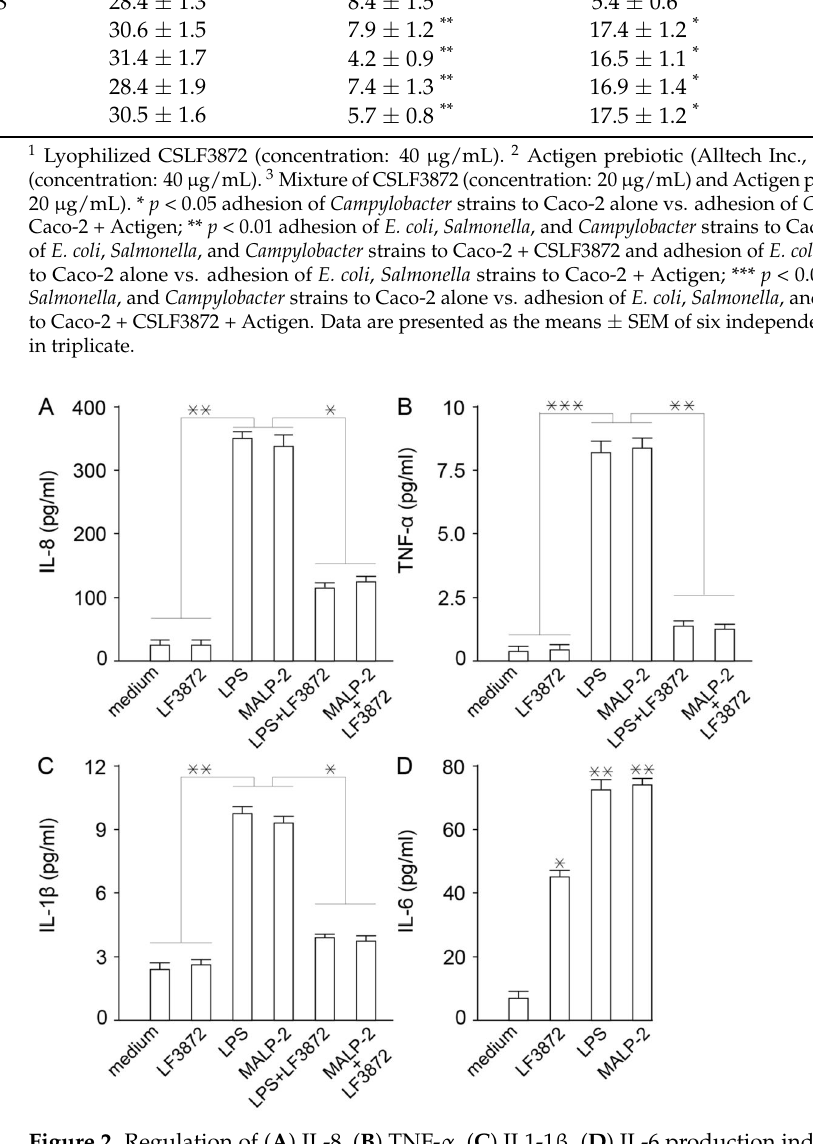
Figure 2. Regulation of ( A ) IL-8, ( B ) TNF- α , ( C ) IL1-1 β , ( D ) IL-6 production induced by